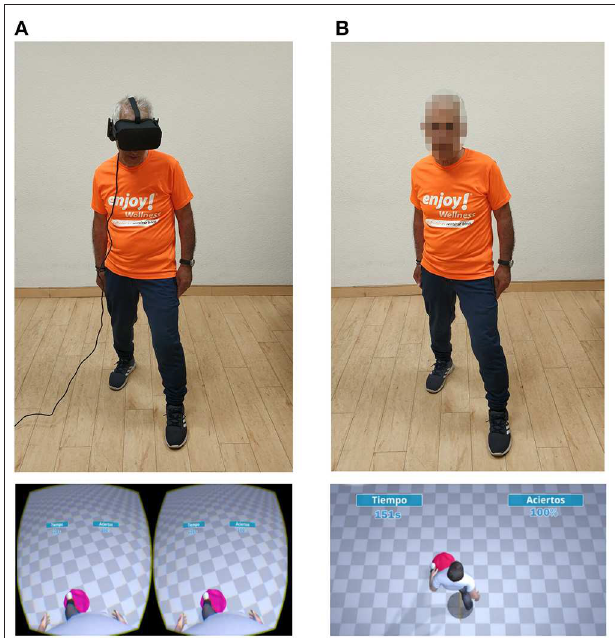
FIGURE 1 | Interaction with the virtual task and virtual environment in first and third-person condition. The figure shows: (A) a participant interacting with the virtual task in first-person perspective (up), and the virtual environment displayed by the HMD (down), and (B) the same participant interacting with the virtual task in third-person perspective (up), and the virtual environment displayed by the screen (B) . In both conditions, the participant is squashing a pink playdough item located on the ground with his left